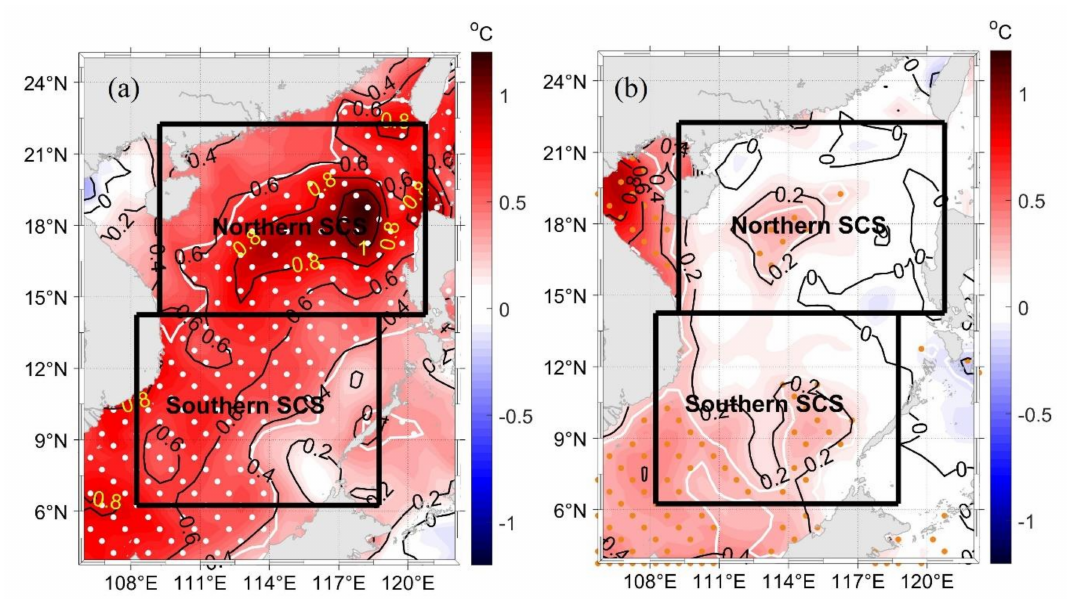
Figure 3. Composites of the SCS SST anomalies in the spring of El Niño decaying years for the ( a ) eastern Pacific (EP) El Niño and ( b ) Central Pacific (CP) El Niño events. The white contours filled with ( a ) white and ( b ) orange dots indicate the composite exceeding the 90% significance level based on a Student’s t test.